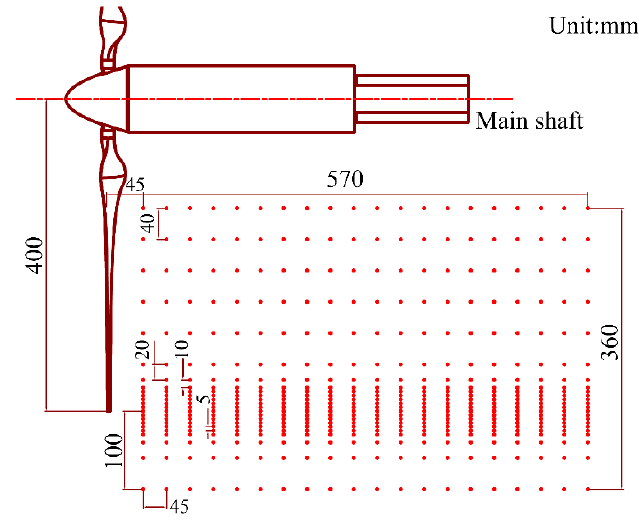
Figure 7. Locations of measurement points.